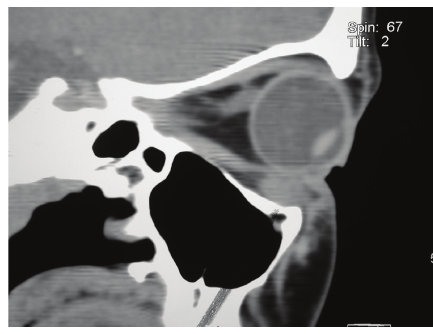
Figure 3: Parasagittal view showing swelling in left inferior oblique.